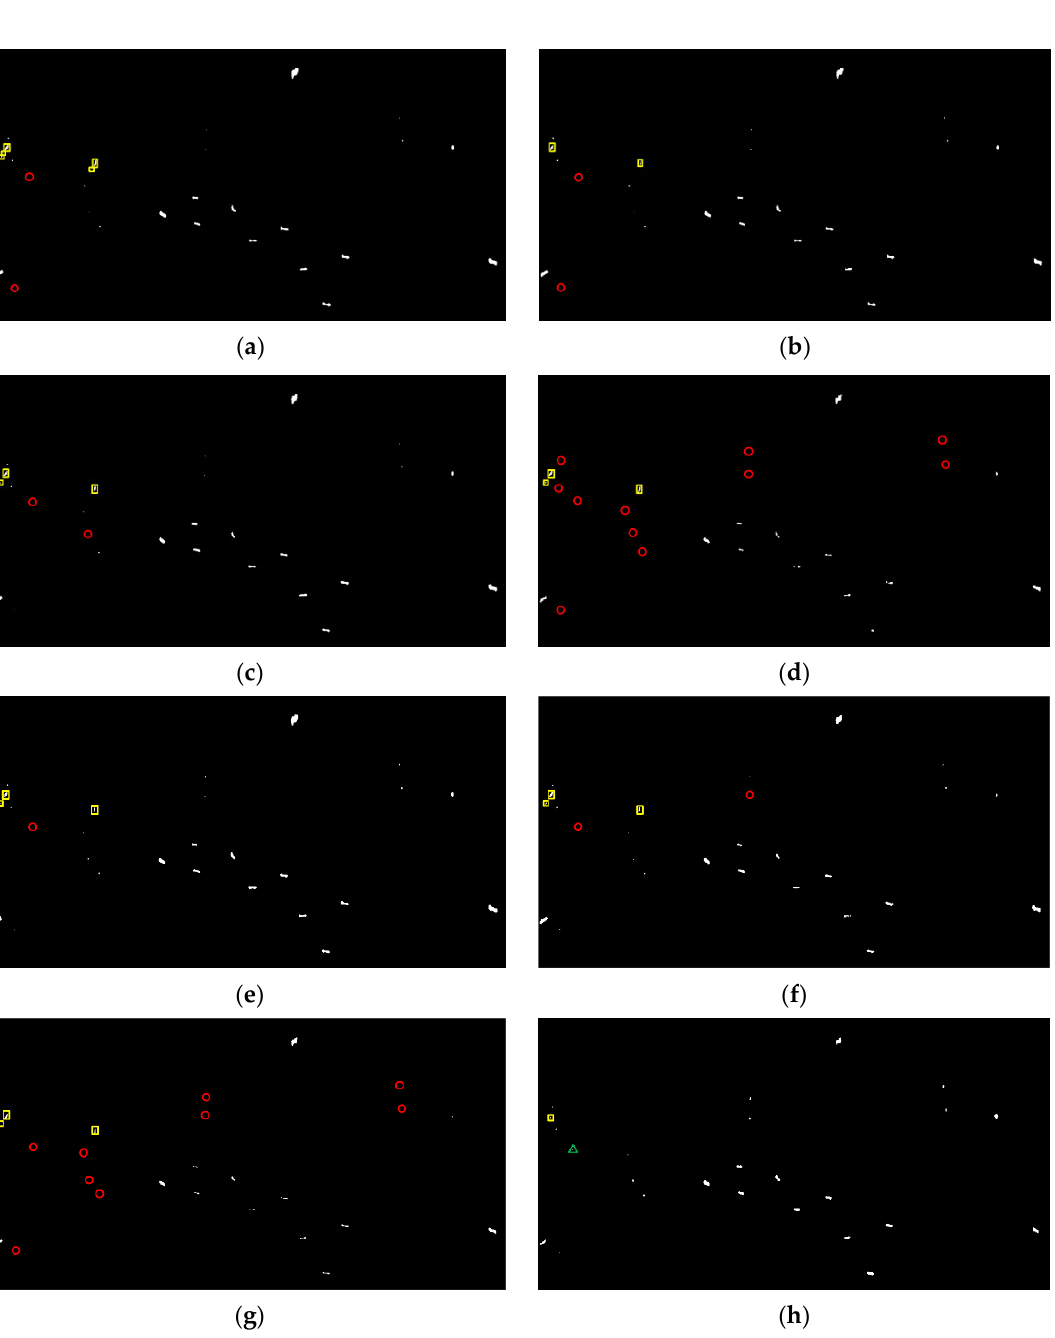
Figure 4. Ship detection results on AIRSAR data. ( a – h ) The PMS, PNF, Pt-Ps, RS, SPAN, DBSPc, VC-CR, and the proposed method, respectively. The red circles, yellow rectangles, and green triangles outline the missed targets, false alarms, and barely visible detected ships, respectively.